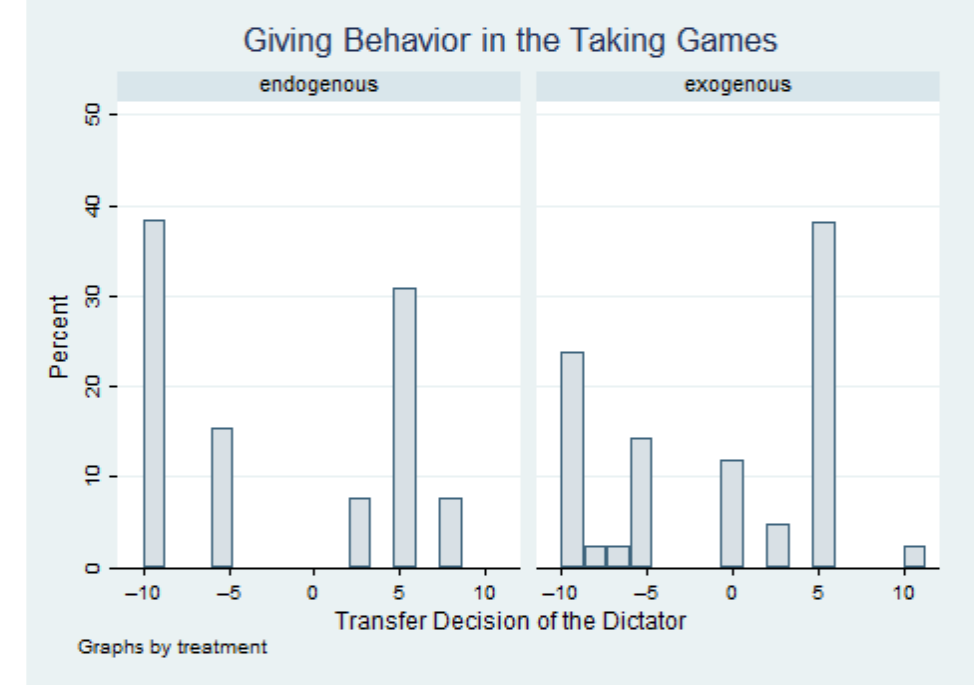
Figure 2. Giving behavior in exogenous and endogenous taking games .